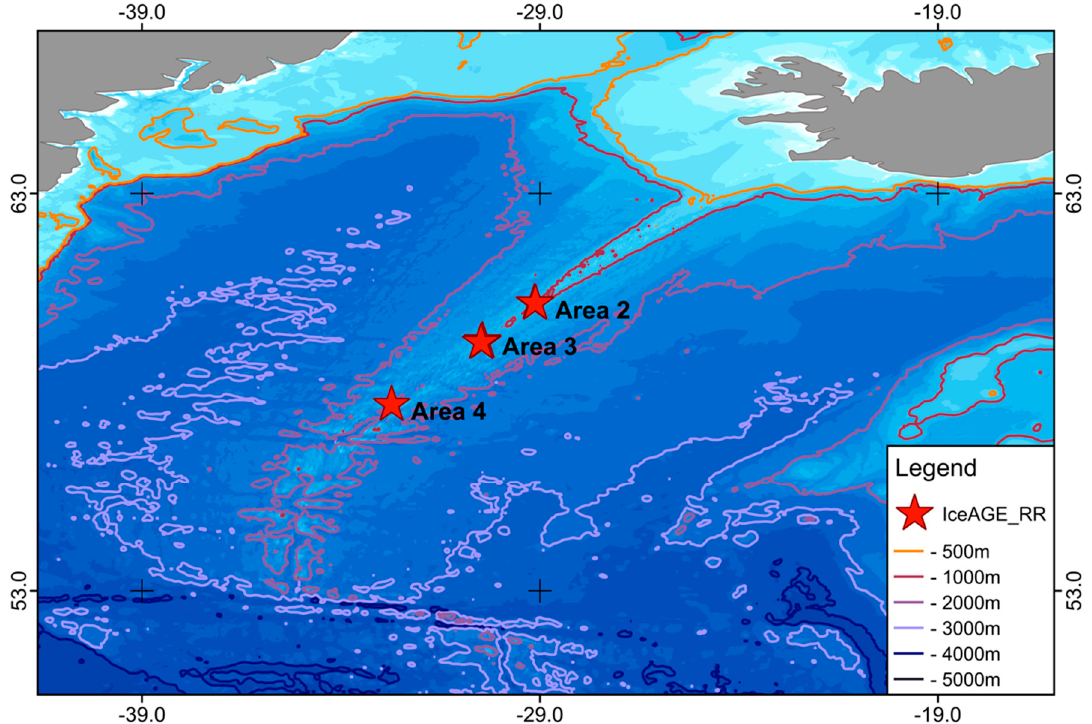
Figure 1. Sampling areas in the North Atlantic south of Iceland. Depth contours are displayed between 500 and 5000 m.